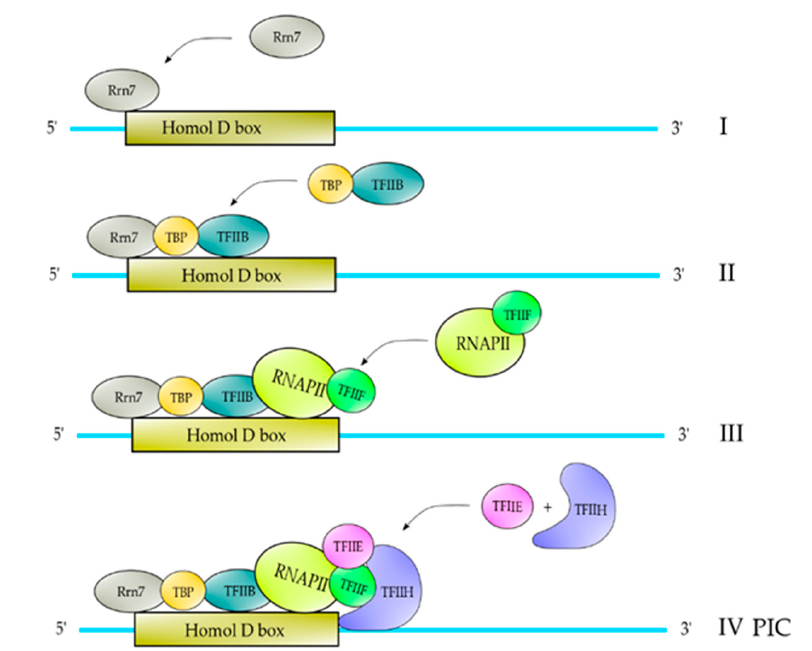
Figure 4. PIC formation on HomolD-box-containing promoters. In the first step of PIC formation, the transcription factor Rrn7 binds to the HomolD-box (I), which in turn is able to recruit the TBP-TFIIB complex (II). After TBP-TFIIB are recruited to the complex, it follows the binding of RNAPII-TFIIF (III), and then the TFIIE and TFIIH are recruited to the complex to form the complete PIC